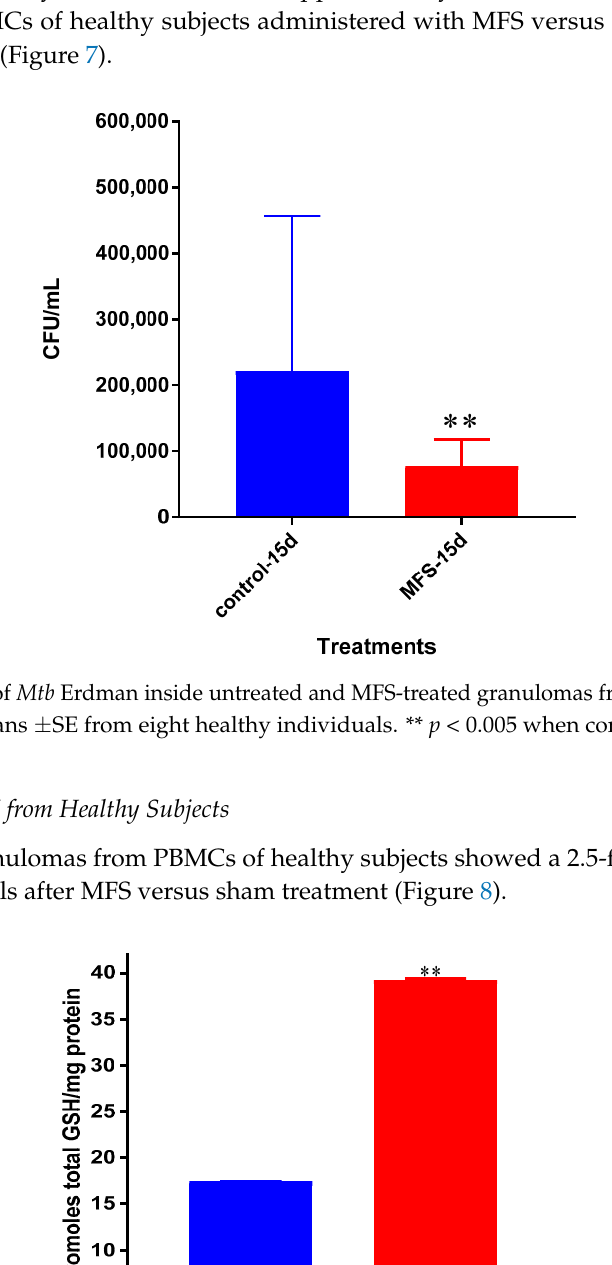
Figure 6. Hematoxylin and Eosin staining of untreated and MFS-treated human granulomas from healthy subjects. Microscopy work was done with a light microscope at 100× magnification under oil immersion.